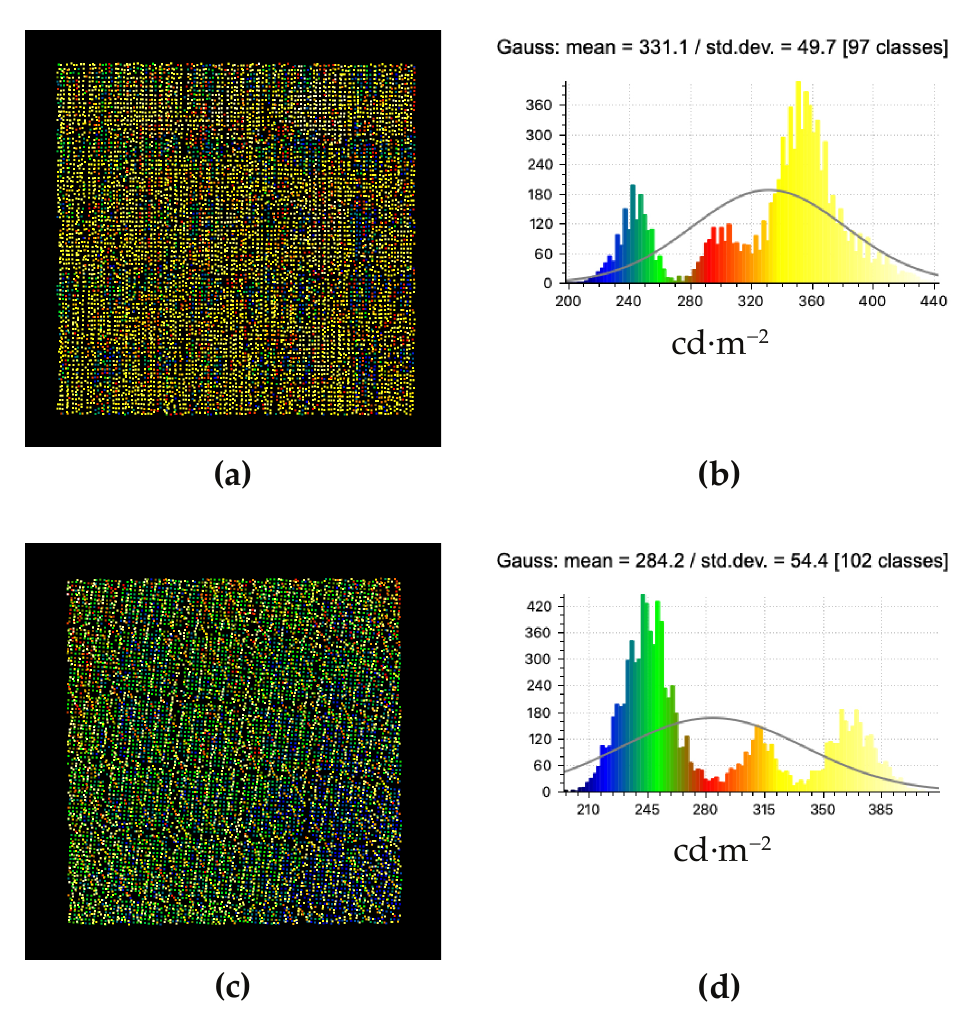
Figure 13. The point cloud ( a ) and its corresponding histogram ( b ) for the vertical sample area, and the point cloud ( c ) and its corresponding histogram ( d ) for the horizontal sample